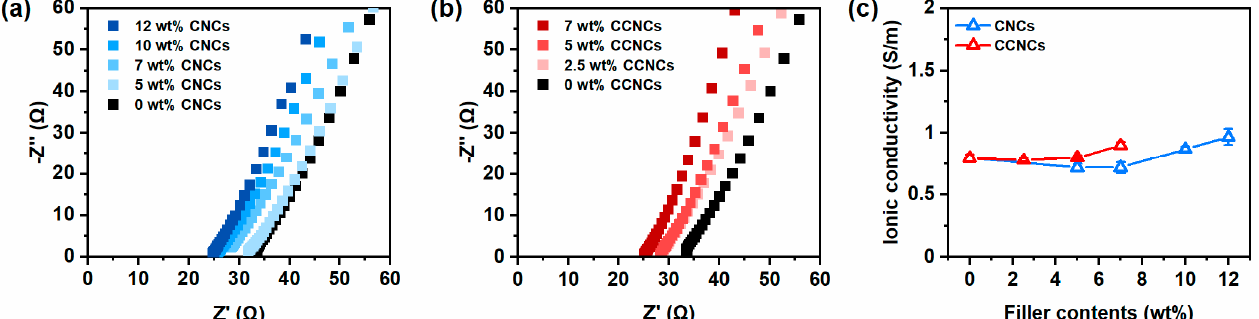
Figure 7. Ionic conductivity of different zwitterionic nanocomposite hydrogels. ( a ) Nyquist plots of the hydrogels with different concentrations of CNCs. ( b ) Nyquist plots of the hydrogels with different concentrations of CCNCs. ( c ) The effect of filler contents on the ionic conductivity, CNCs (blue) and CCNCs (red).